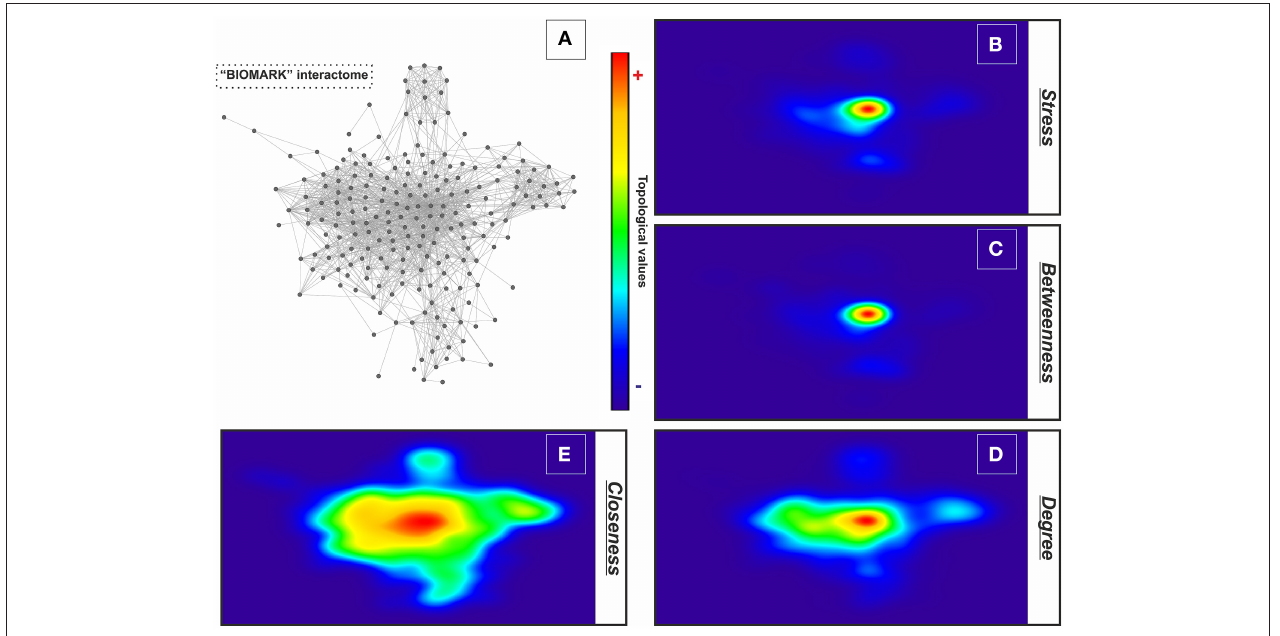
FIGURE 4 | GALANT plots of centrality values over the “BIOMARK” interactome. Analysis of the topological network properties by Cytoscape and its 2D projection by the GALANT software over the "BIOMARK" interactome (A) show the areas of maximum values (red color) of stress (B) , betweenness (C) , degree (D) , and closeness centralities (E) of each node in this color-grading